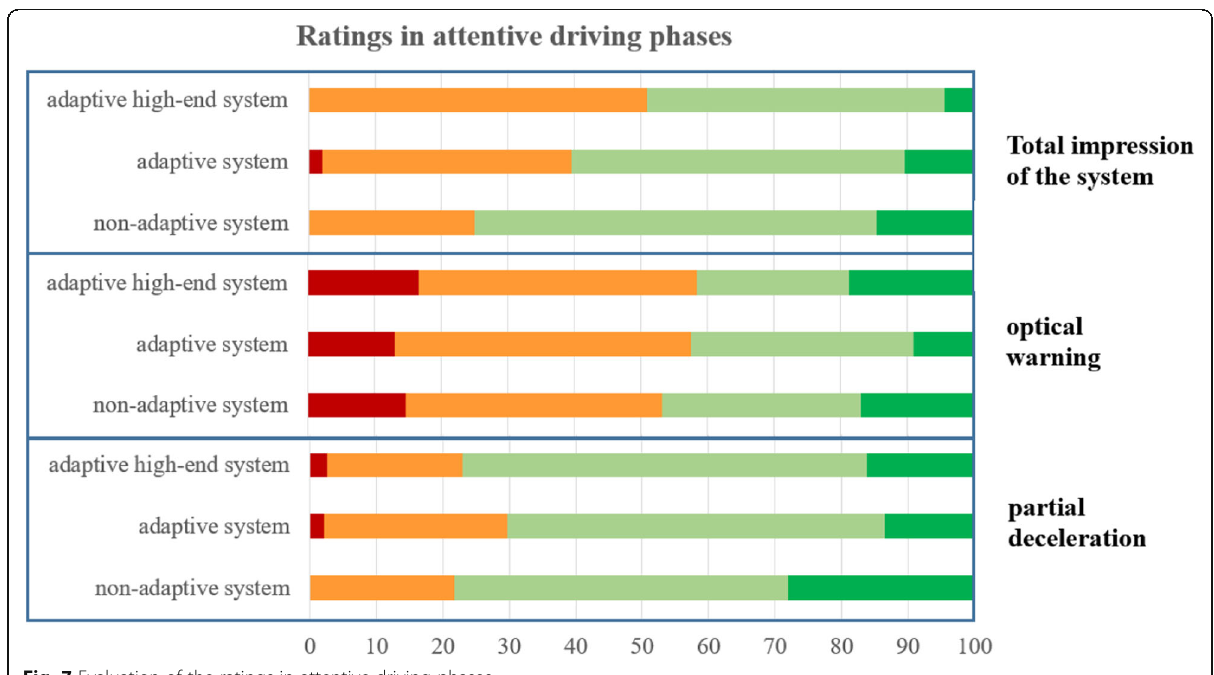
Fig. 7 Evaluation of the ratings in attentive driving